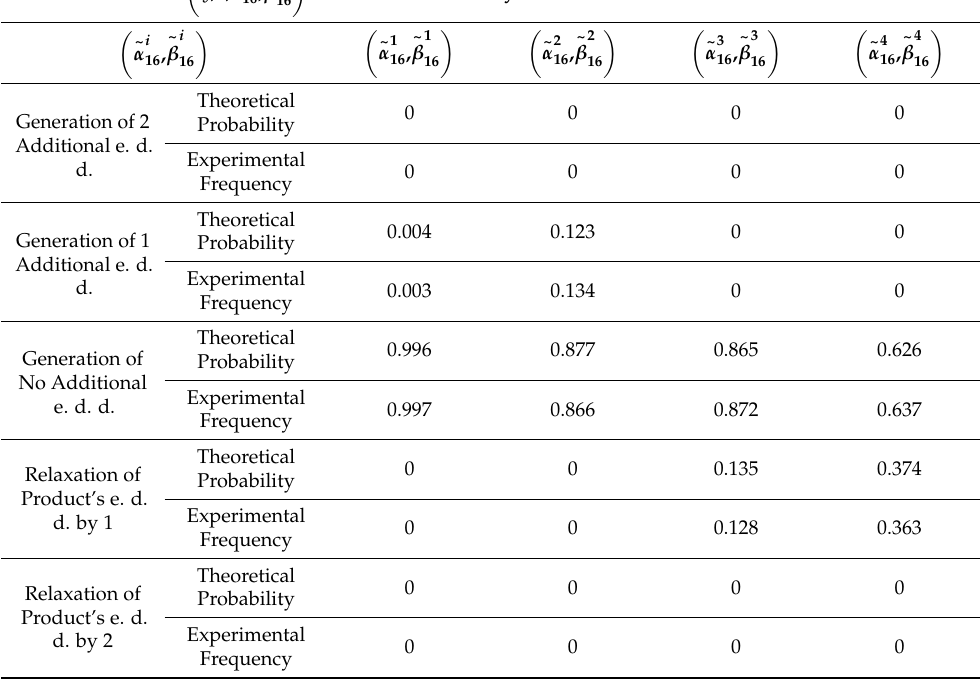
(cid:16) (cid:17) ξ ,2; (cid:101) α i , namely for the case where # edd , (cid:101) β i 16 16 (cid:16) (cid:17) (cid:0) (cid:1) − ι # edd (cid:101) β ι 16 (cid:101) γ 16